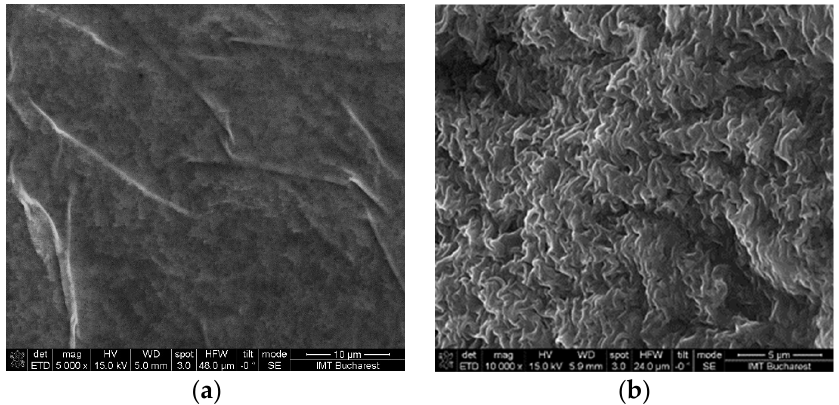
Figure 7. Morphology of the V5 hydrogel after 5 days of drying at room temperature: (a) SEM image of amorphous hydrogel and (b) SEM image of crosslinked hydrogel.